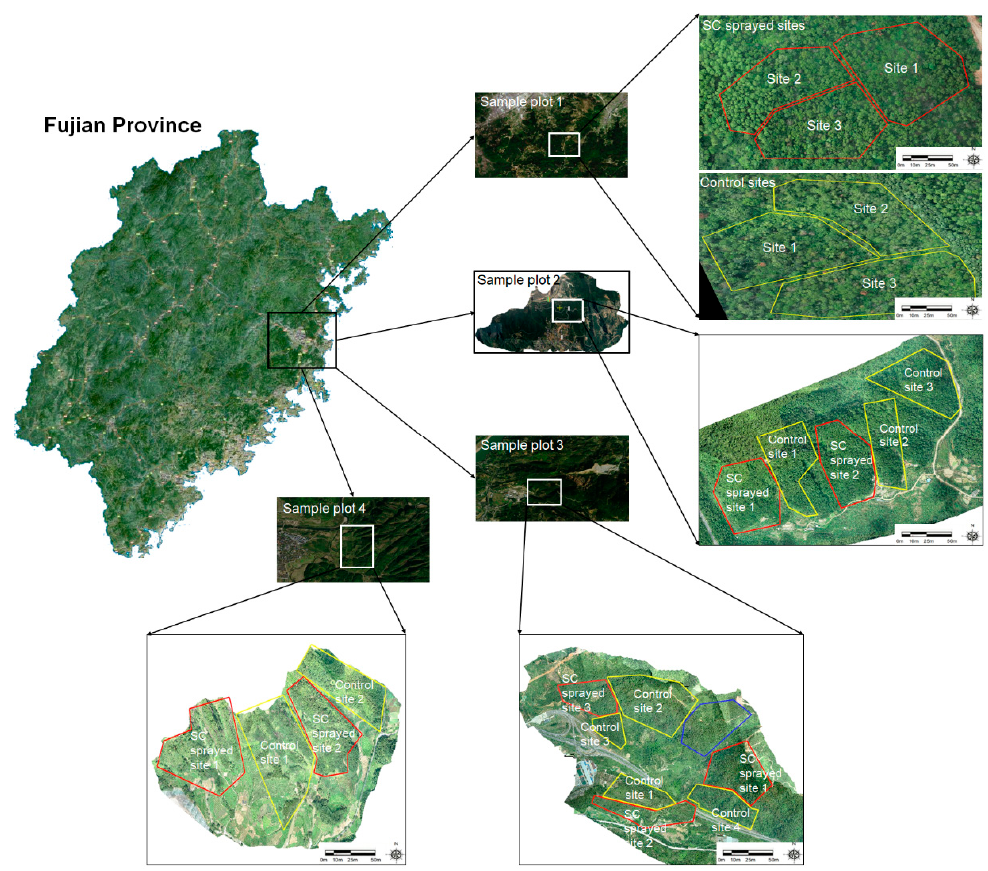
Figure 2. Map of sampling plots used for spraying fluopyram suspension concentrate. Plot 1: Qingkou, Minhou County, China (25 ◦ 52 (cid:48) 9.00 (cid:48)(cid:48) N, 119 ◦ 22 (cid:48) 21.03 (cid:48)(cid:48) E). Plot 2: Jin’an District, Fuzhou City, China (26 ◦ 6 (cid:48) 42.46 (cid:48)(cid:48) N, 119 ◦ 23 (cid:48) 24.47 (cid:48)(cid:48) E). Plot 3: Hongwei, Minhou County, China (26 ◦ 10 (cid:48) 58.60 (cid:48)(cid:48) N, 119 ◦ 1 (cid:48) 14.04 (cid:48)(cid:48) E). Plot 4: Wuyishan National Park, China (27 ◦ 38 (cid:48) 11.54 (cid:48)(cid:48) N, 117 ◦ 55 (cid:48) 58.62 (cid:48)(cid:48)